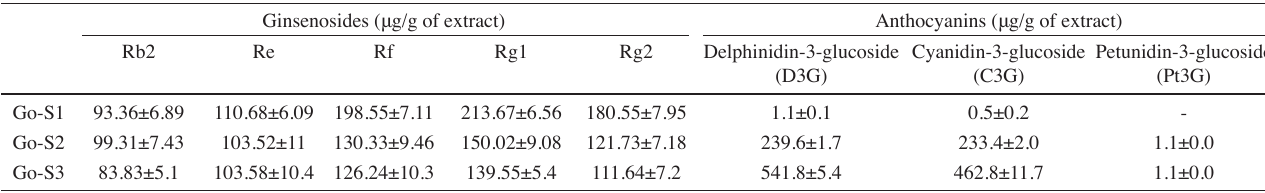
Tab. 2: Content of ginsenosides and anthocyanins of ginseng berry in different ripening